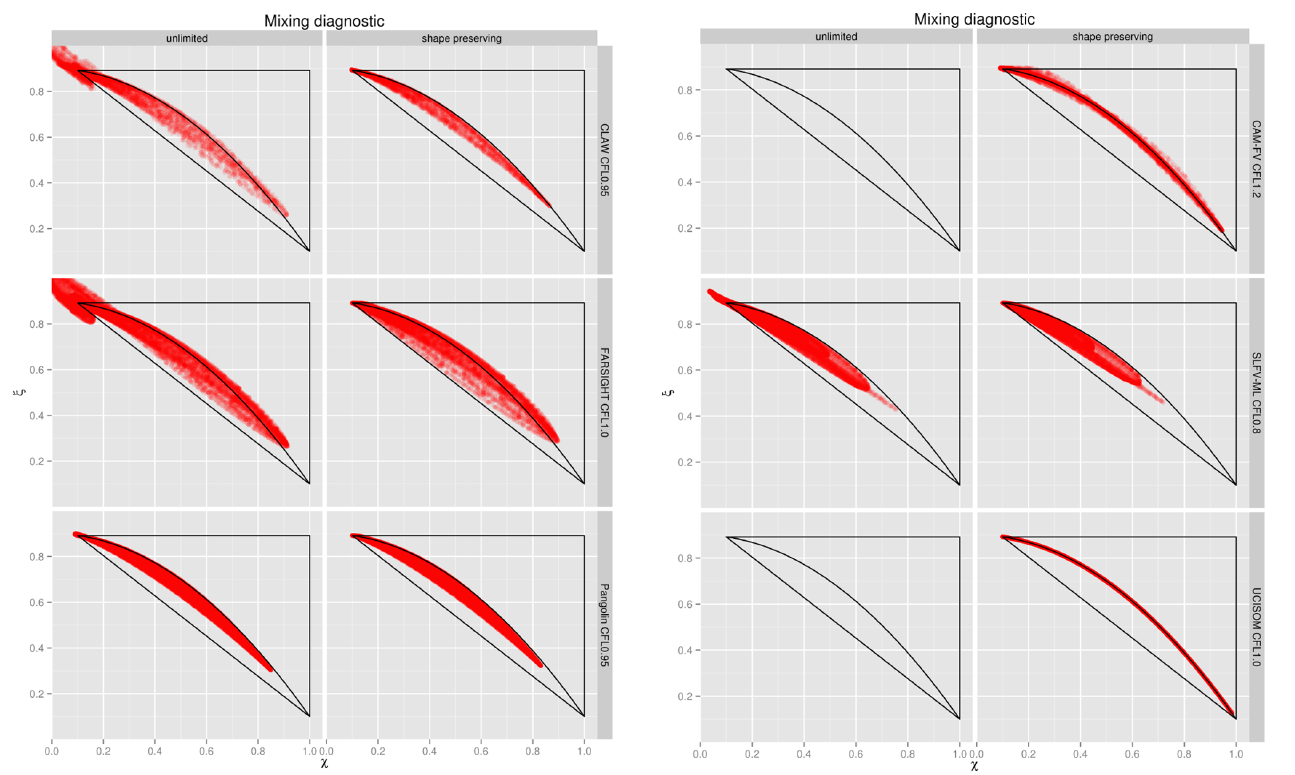
Figure 13. Mixing plots for both unlimited and shape-preserving versions. The resolution is set at 0 . 75 ◦ at the Equator, except for Pangolin, which has 0 . 376 ◦